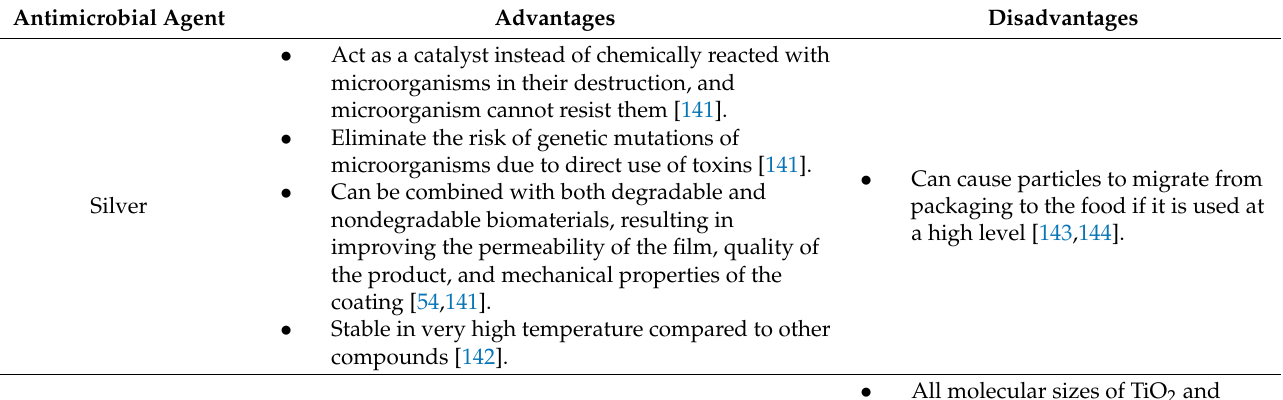
Table 5. Advantages and disadvantages of widely used materials of antimicrobial agent for food packaging